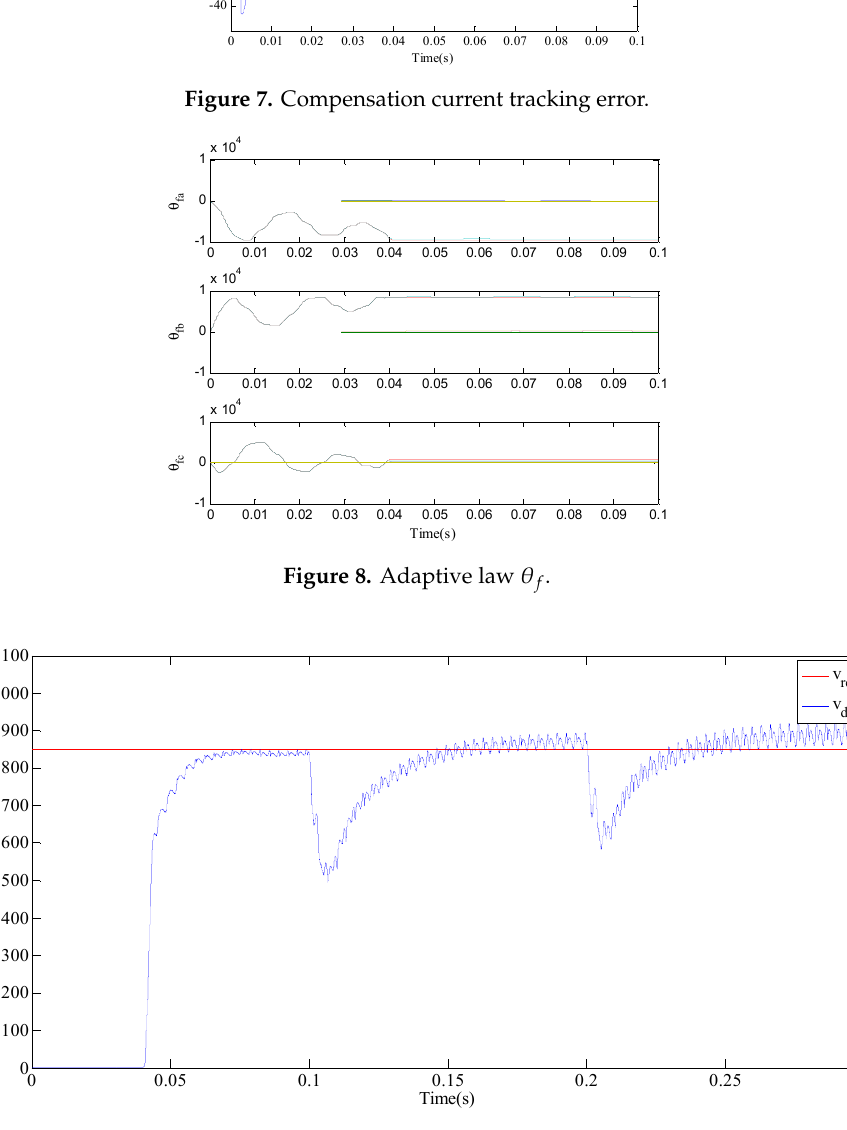
Figure 9. DC capacitor voltage with the load increasing.